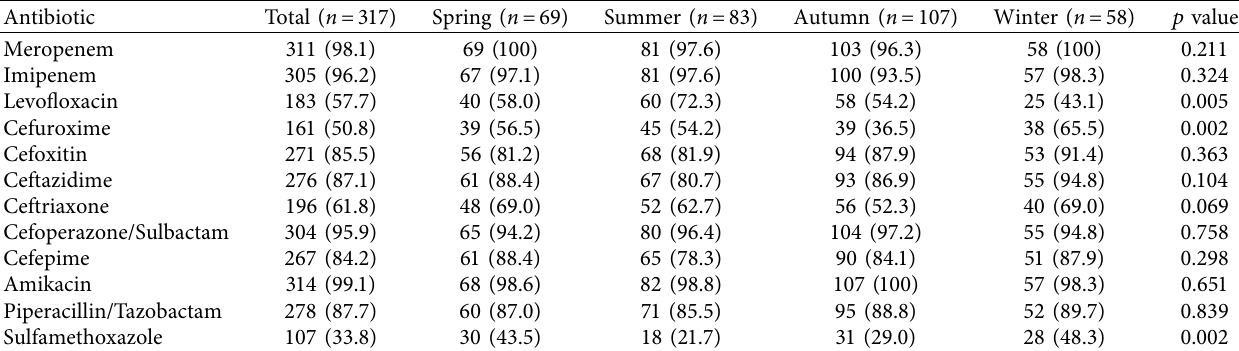
Table 4: Antibiotic sensitivity of Proteus mirabilis isolated from urine of patients with urinary calculi in diferent seasons (%).